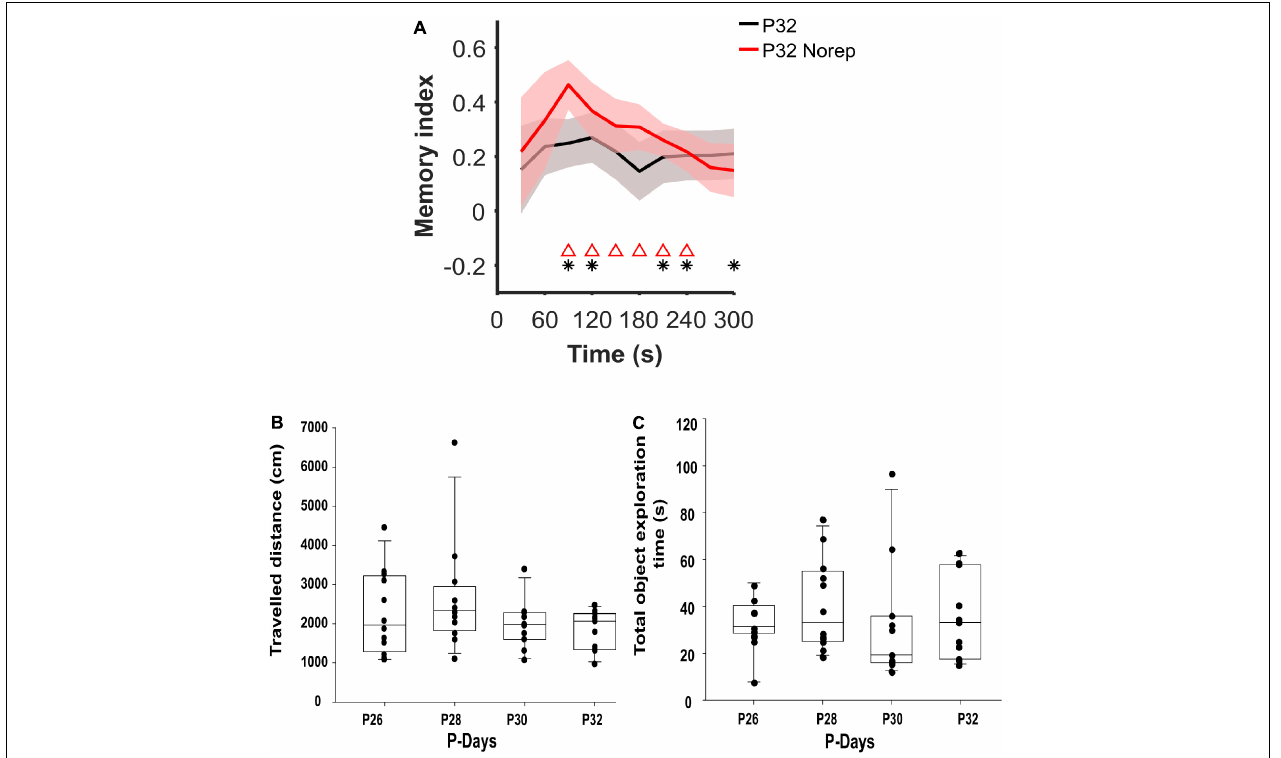
FIGURE 2 | Memory emergence is not due to task overtraining. (A) Object memory index (Mean ± SEM) at P32 of repetitive exposure to the OPR task was compared with animals that performed the task without previous exposure (P32 NoRep). The memory indexes for the entire task duration (5 min, 30 s/bin) for P32 (black line) and P32 NoRep group (red line) indicated significant differences to the chance level ( p < 0.0420), two-sided Wilcoxon-signed-rank for P32 (dark asterisk) and p < 0.0195 for P32 NoRep (red triangles). Groups P32 and P32 NoRep showed no significant differences ( p > 0.0569, two-sided Wilcoxon rank-sum test). (B) No differences between the traveled distance during the 5-min of memory encoding at different rat ages were found [ p = 0.08, One Way Repeated Measures Analysis of Variance F ( 3 , 11 ) = 2.479]. (C) No differences between the total object exploration time were found, [ p = 0.609, Friedman repeated-measures ANOVA on ranks, F ( 3 , 11 ) = 0.617]. The halfway mark indicates the median on each box, while the bottom and top edges indicate the 25th and 75th percentiles. P26 and P28, n = 12; P30 and P32, n =